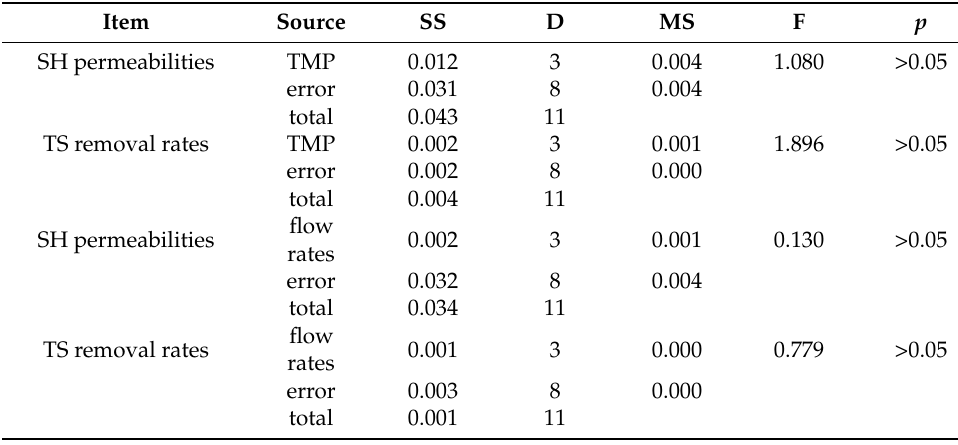
Table 5. ANOVA results of SH permeabilities and TS removal